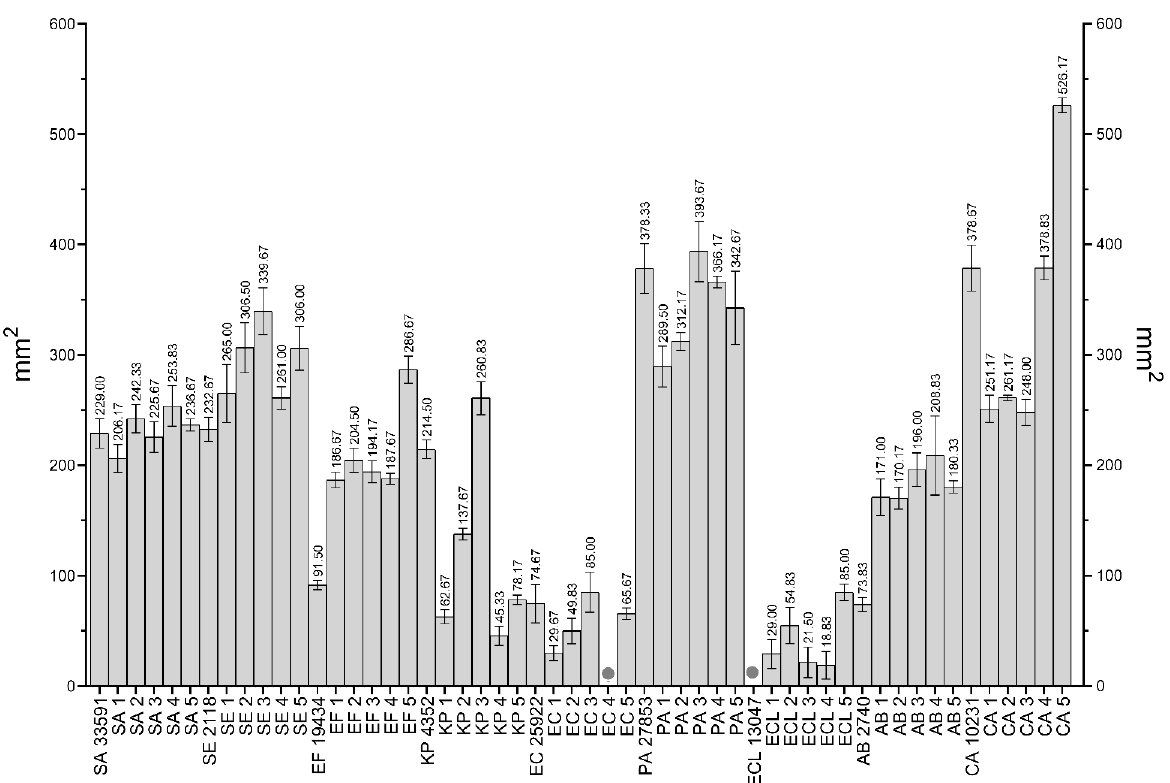
Figure 14. Average growth inhibition zones caused by silver dressing (mm 2 ). The antimicrobial agent was silver dressing (Aquacel ® Ag, ConvaTec, Berkshire, England). Dots indicate strains against which the silver dressing was ineffective. Tested strains: SA — Staphylococcus aureus , SE — Staphylococcus epidermidis , EF — Enterococcus faecium , KP — Klebsiella pneumoniae , EC — Escherichia coli , PA — Pseudomonas aeruginosa , ECL — Enterobacter cloacae , AB — Acinetobacter baumannii , CA — Candida albicans .